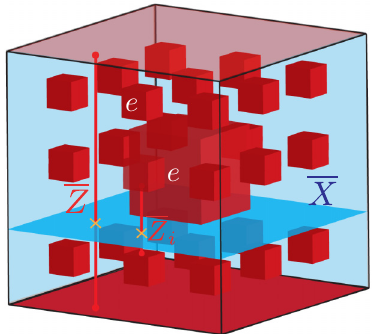
FIG. 16. A 3D fractal model defined on the fractal-cube geom- etry FC ( 3, 1 ) with only e -holes (red). A pair of macroscopic log- ical operators X and Z intersects at a single point (yellow cross). The macroscopic logical X is intersected by an O ( 1 ) -length dual logical string Z i , leading to an O ( 1 ) code